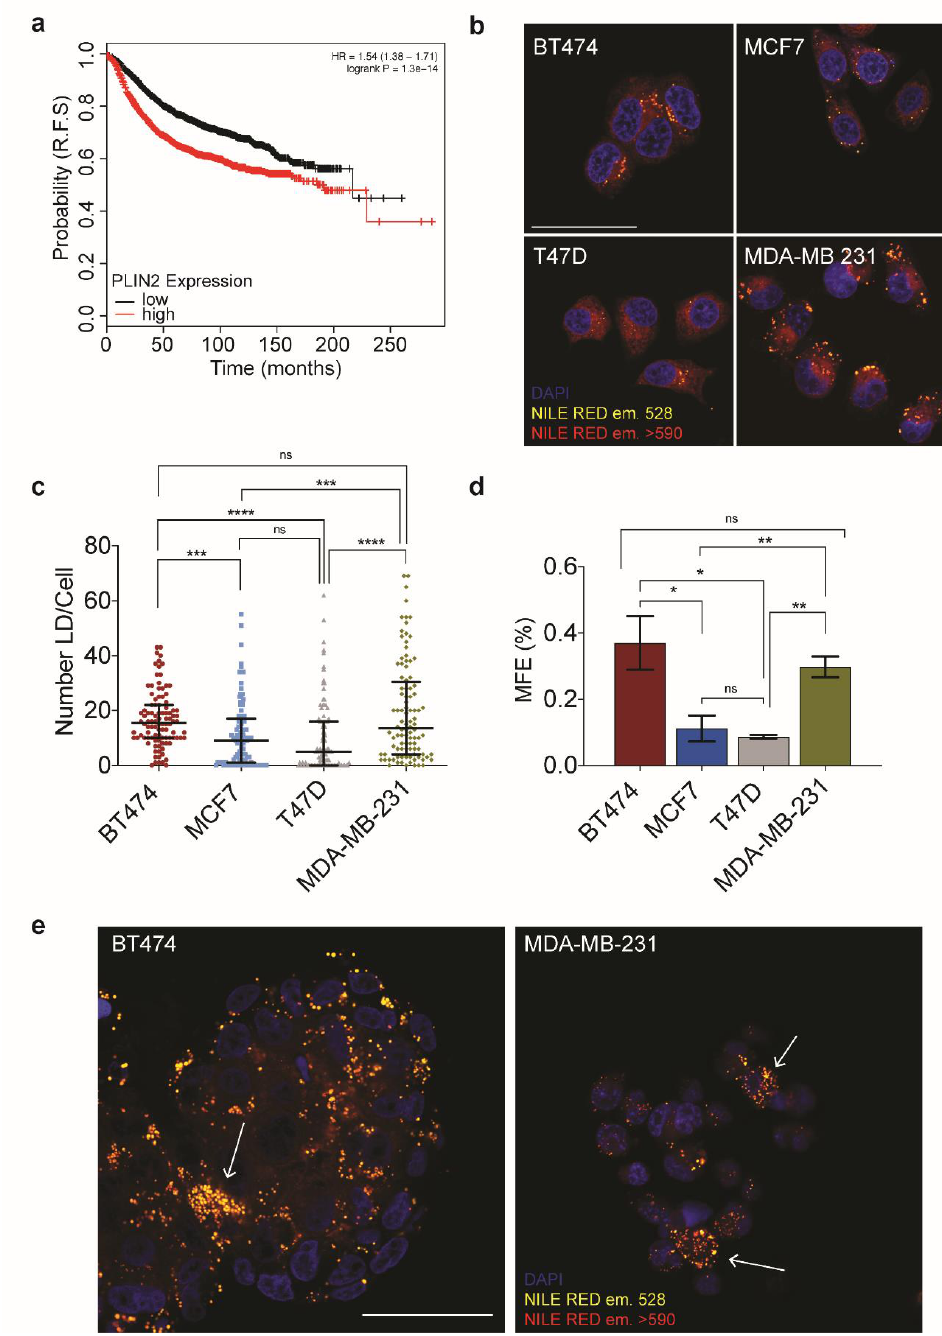
Figure 1. Lipid droplets correlate with breast cancer progression and stemness. ( a ) The effect of PLIN2 expression on relapse-free survival in breast cancer ( b ) Confocal imaging of Nile Red stained BT474, MCF7, T47D, and MDA-MB-231. The scale bar represents 50 μ m. ( c ) Quantification of lipid droplets number/cell for 100 cells per cell line (right). ( d ) Mammosphere formation efficiency for the four cell lines used in this study. ( e ) Confocal imaging of mammospheres stained with Nile Red, arrows indicate lipid droplet enriched cells, scale bar represents 50 m. Data are represented as mean ± SEM. Significance was calculated using two-tailed t -tests. * p < 0.05, ** p < 0.01, *** p < 0.001, **** p < 0.0001.